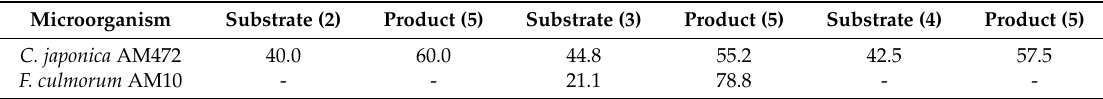
Table 2. Results of the preparative scale biotransformations of halolactones 2 – 4 after 7 days of incubation (in % according to GC).